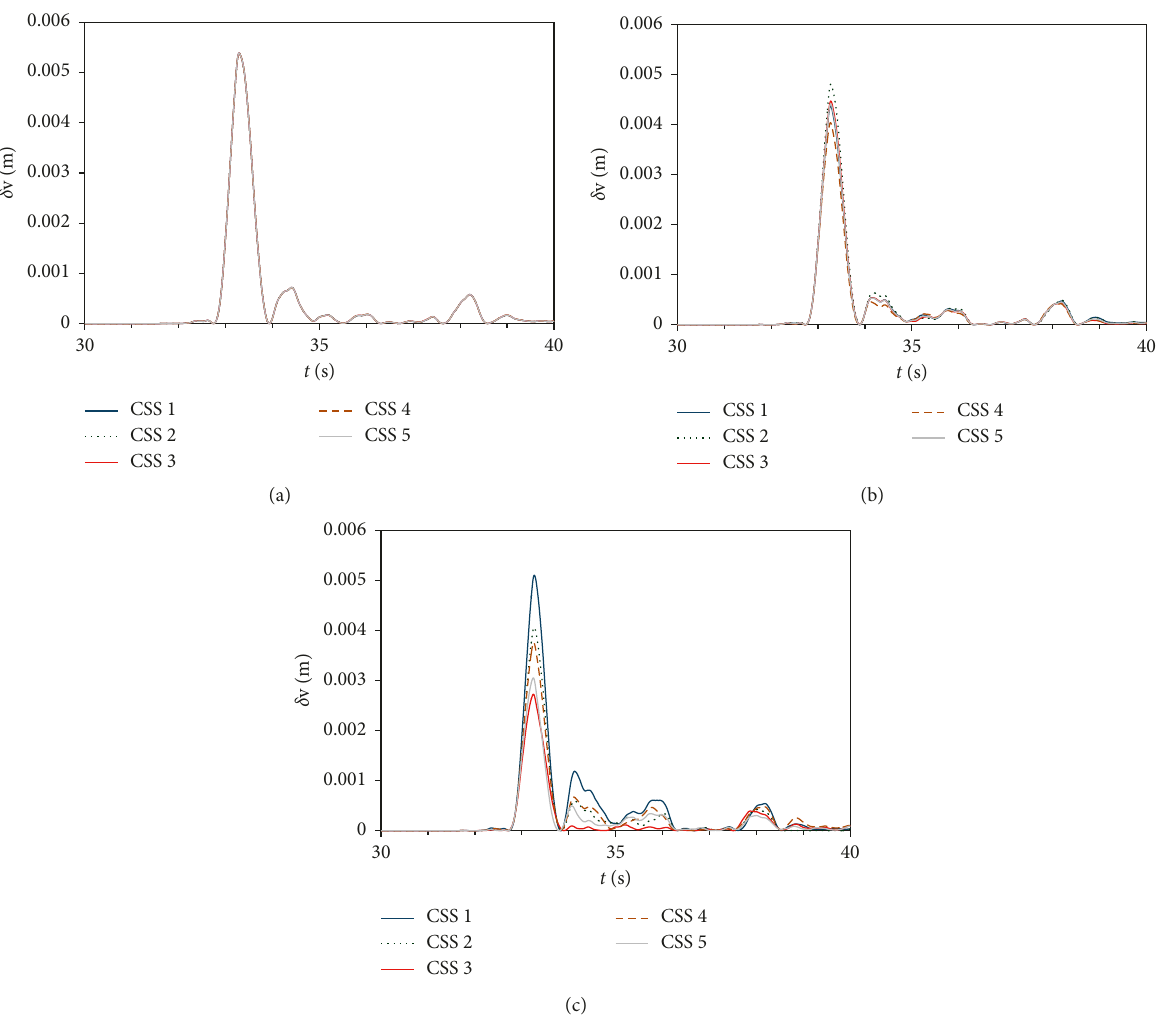
Figure 18: Five columns frame: vertical displacements with 3D input for (a) C10, (b) C23 with μ